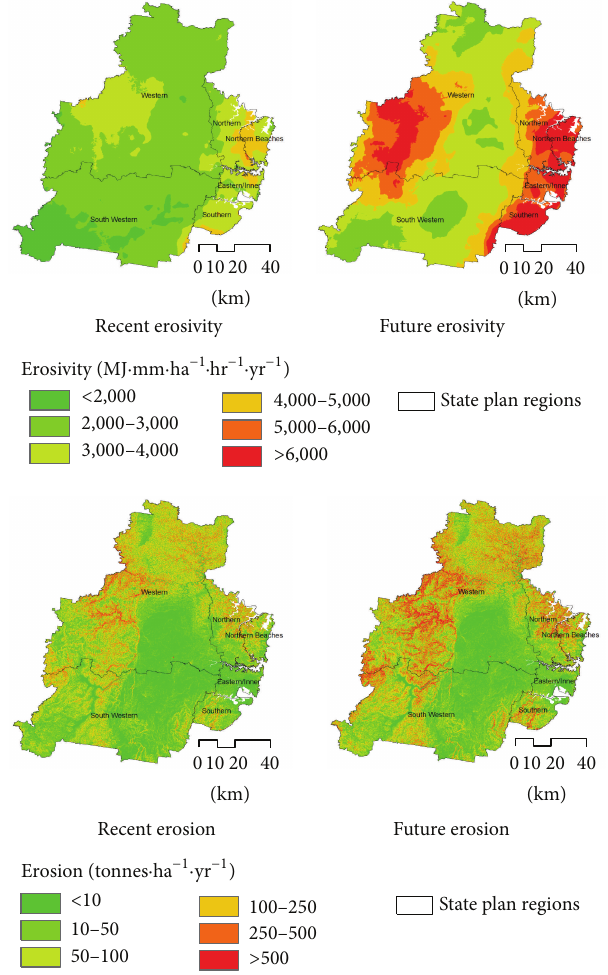
Figure 8: Modeled mean annual rainfall erosivity and hillslope erosion in Sydney